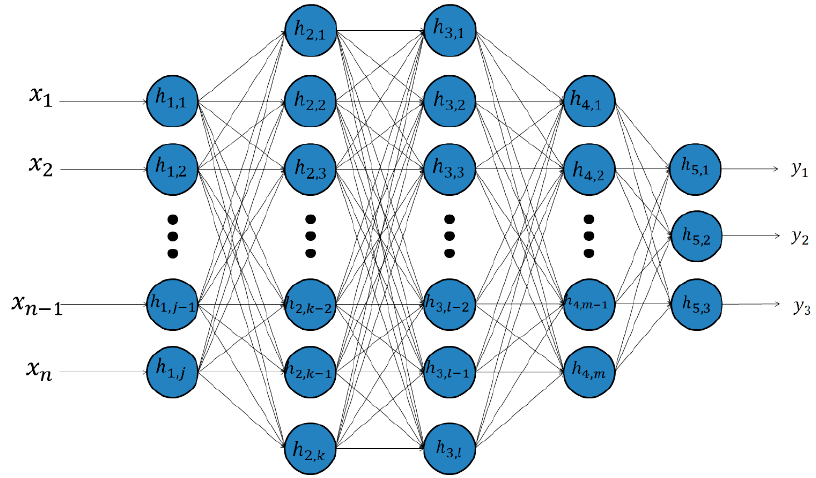
Figure 2. Deep neural network.